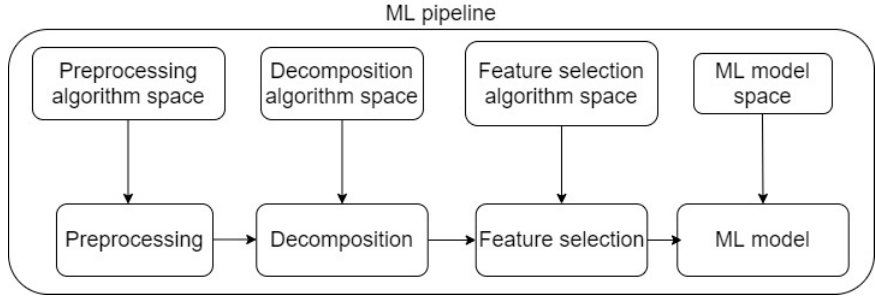
Figure 6. Schematic of a ML pipeline in TPOT.